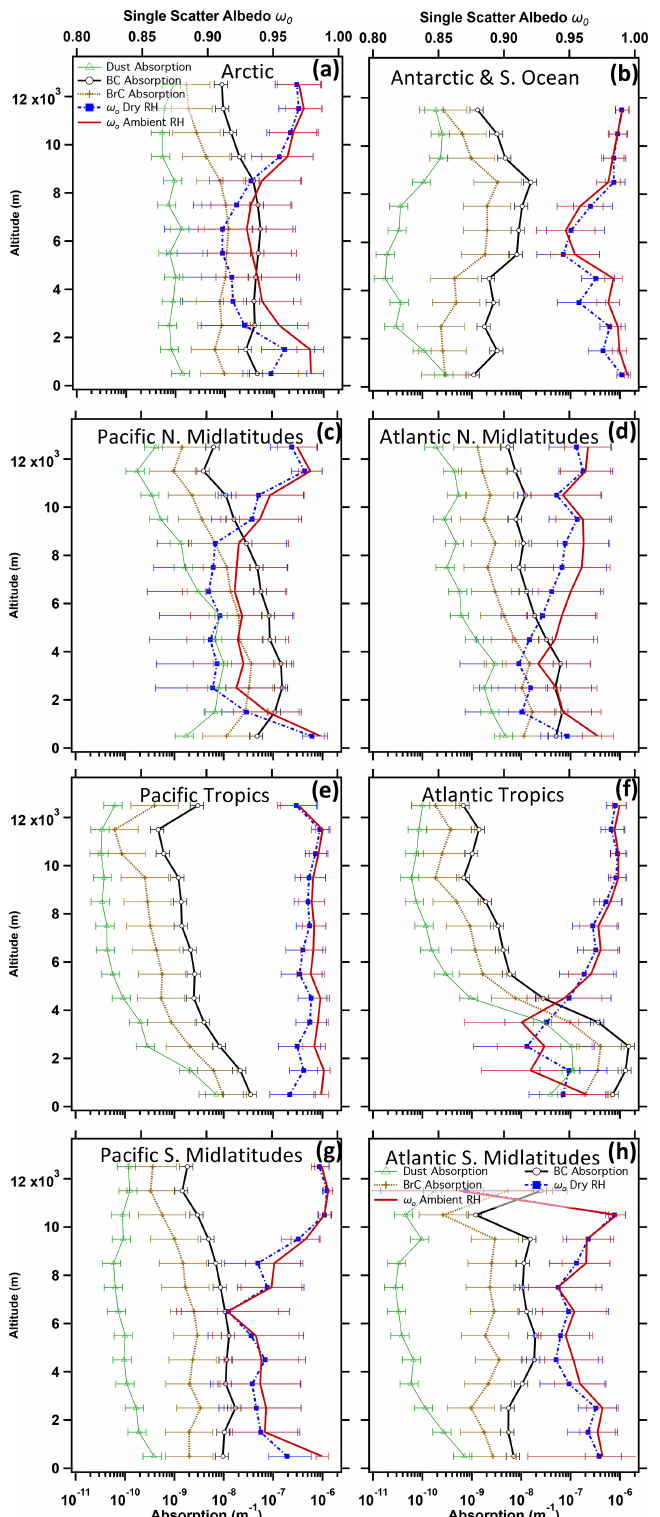
Figure 13. Median vertical profiles of absorption at the 532nm wavelength from rBC, BrC, and dust (bottom axis) as well as single- scattering albedo ω 0 at 532nm wavelength dry and ambient RH conditions (top axis) for different regions sampled during the entire ATom project. (a) Arctic. (b) Antarctic and Southern Ocean. (c) Pacific northern midlatitudes. (d) Atlantic northern midlatitudes. (e) Pacific tropics. (f) Atlantic tropics. (g) Pacific southern midlatitudes. (h) Atlantic southern midlatitudes. https://doi.org/10.5194/acp-21-15023-2021 Atmos. Chem. Phys., 21, 15023–15063,